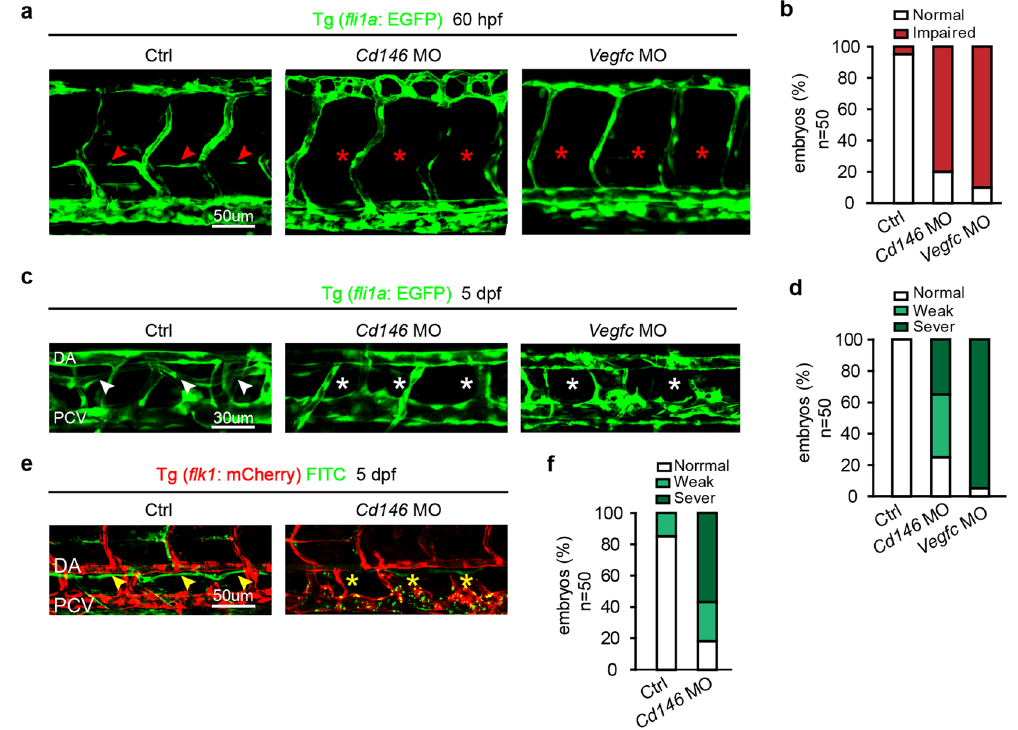
Figure 6. Knockdown of CD146 disrupts lymphangiogenesis in zebrafish. ( a , b ) The effects of cd146 or vegfc knockdown on PL formation. Tg ( fli1a : EGFP) embryos, injected with control, cd146 or vegfc specific MO, were harvested at 60 hpf. Confocal images showed normal PL (red arrows) and impaired PL (red stars) in ( a ). Scale bars: 50 μ m. The percentages of embryos with normal PL cells (normal) and impaired PL string formation (impaired PLs) were shown in ( b ). ( c , d ) The effects of cd146 or vegfc knockdown on TD formation. Tg ( fli1a : EGFP) embryos, injected with control, cd146 or vegfc specific MO, were harvested at 5 dpf. Confocal images showed normal TD (white arrows) and abnormal TD (white stars) in ( c ). Scale bars: 30 μ m. The percentages of embryos with different phenotypes of TD formation were shown in ( d ). Relative to the normal embryos, the TD length decreased to 30–90% were classified as weak, and those decreased to 10–30% were classified as severe. ( e , f ) The effects of cd146 knockdown on TD function. Tg ( flk1 : mcherry) zebrafish embryos injected with control or cd146 specific MO and FITC-dextran was injected subcutaneously in the tail of those fishes. The embryos were harvested at 5 dpf. Confocal images showed functional TD (yellow arrows) and dysfunctional TD (yellow stars) in ( e ). Scale bars: 50 μ m. The percentages of embryos with different phenotypes of TD formation were shown in ( f ). The criterion used to classify the TD formation was the same as that used in ( d ). In all panels, the head of the embryo faces left and dorsal is